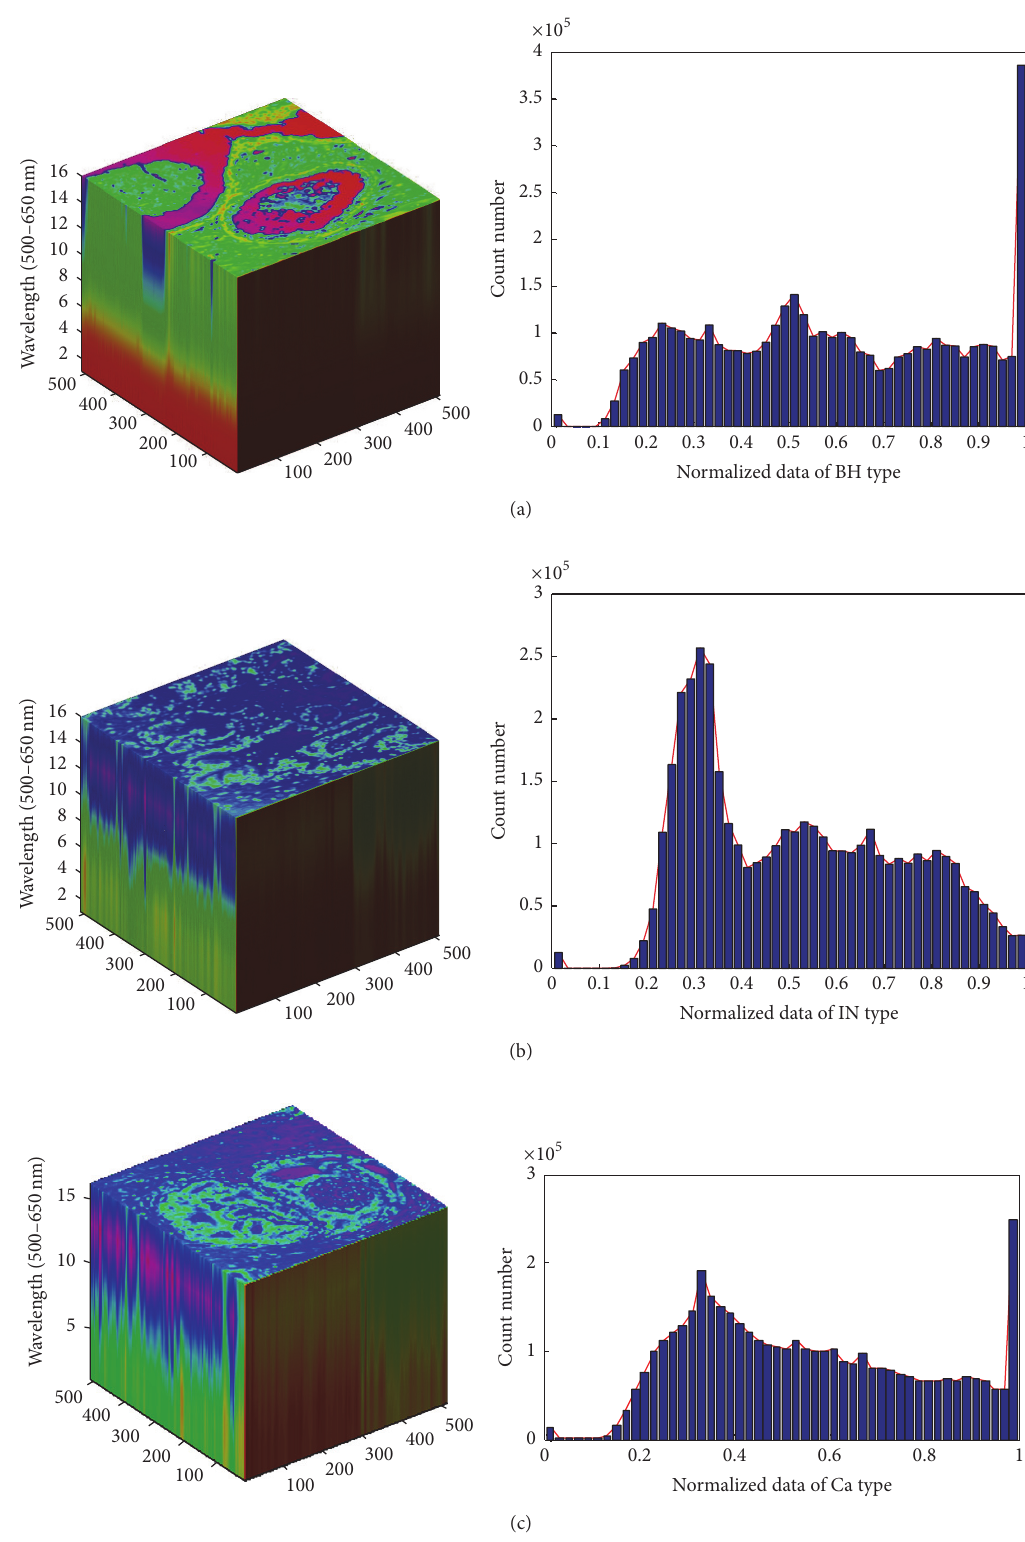
Figure 1: Multispectral images of three types from abnormal cells showed differences in shape and histograms. These images come from colorectal biopsies viewed under optical microscopy systems ( × 40 objective magnification). (a) Benign hyperplasia, (b) intraepithelial neoplasia, and (c)